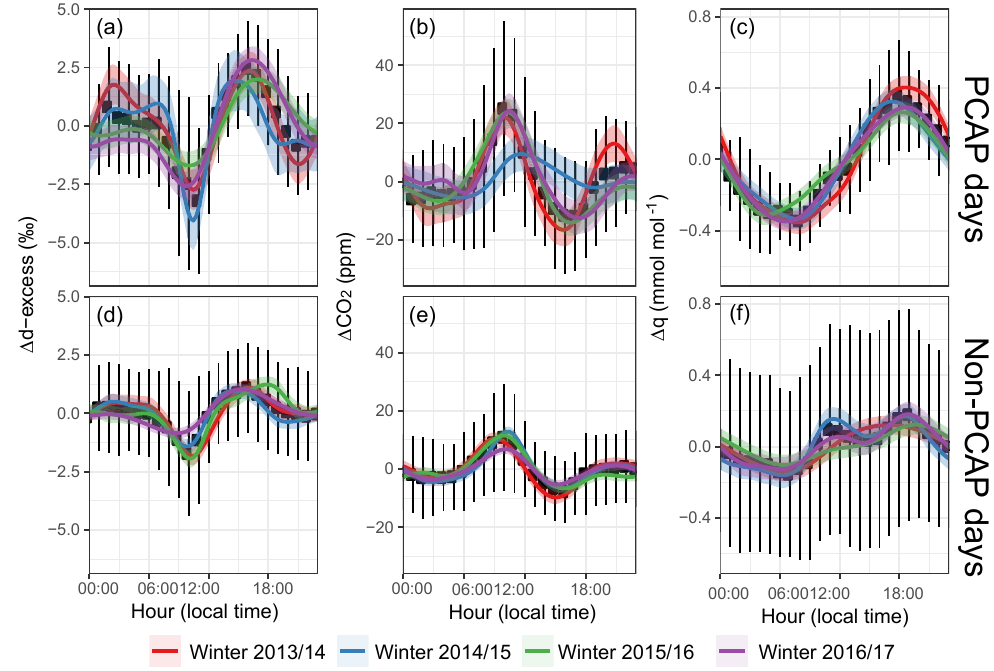
Figure 8. Seasonal average diurnal cycles of (cid:49) d-excess (a, d) , (cid:49) CO 2 (b, e) , and (cid:49)q (c, f) for days in PCAP conditions (a–c) or non-PCAP conditions (d–f) . The diurnal cycle is approximated here as the deviation from a 24h moving average. Mean values across all four years are shown as black symbols, with black vertical lines indicating 1 σ variability. The mean diurnal cycle is modeled for each year independently as a GAM using cubic cyclic smoothing splines, and regression standard error shown as shaded ribbons, with the color corresponding to model